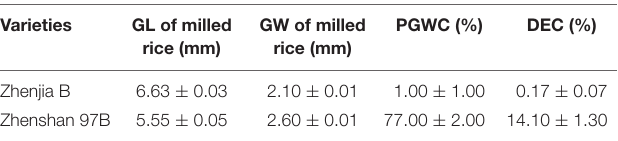
TABLE 1 | The phenotypes of the parents.